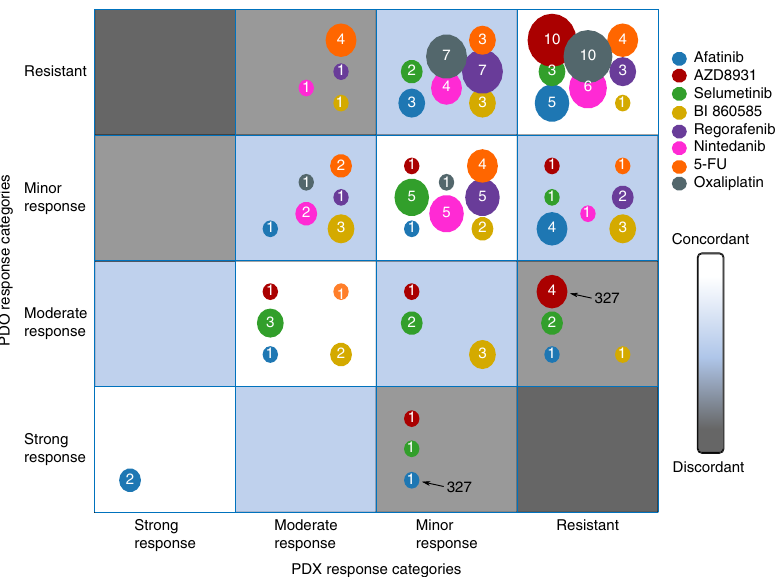
Figure 7 | Bubble plot comparison of drug sensitivity profiles in 19 sibling pairs of PDX and PDO models. Drug response categories are displayed on the axes ( x ¼ PDX, y ¼ PDO). The size of each bubble is proportional to the number of model pairs in a given response category, where this number is indicated in the bubbles. The colours represent the eight drugs tested in both model systems, as indicated in the caption. The background colour in each square indicates the degree of concordance between the two models where grey indicate discordant drug response.